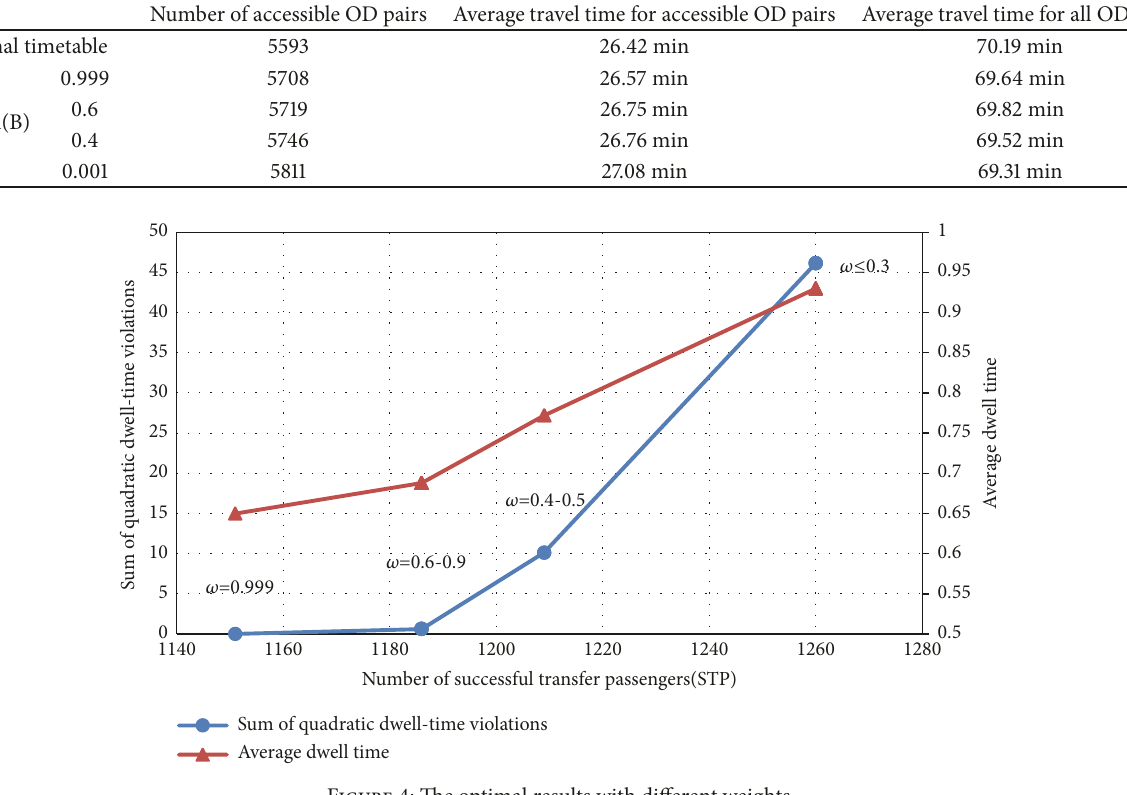
Figure 4: The optimal results with different